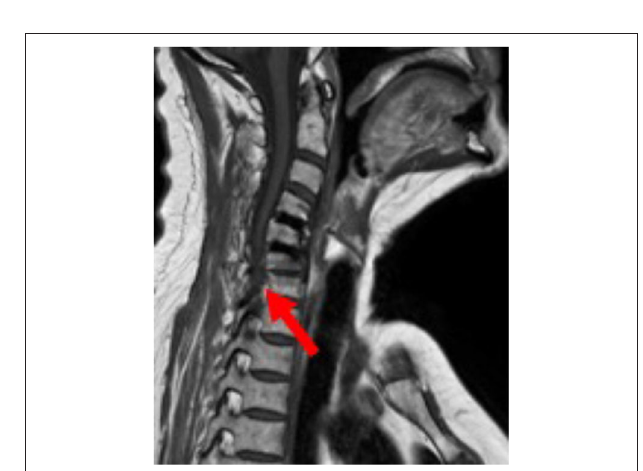
FIGURE 2 | MRI double level EIT CIF cage 2 years postop Arrow indicates spinal stenosis C6/C7.